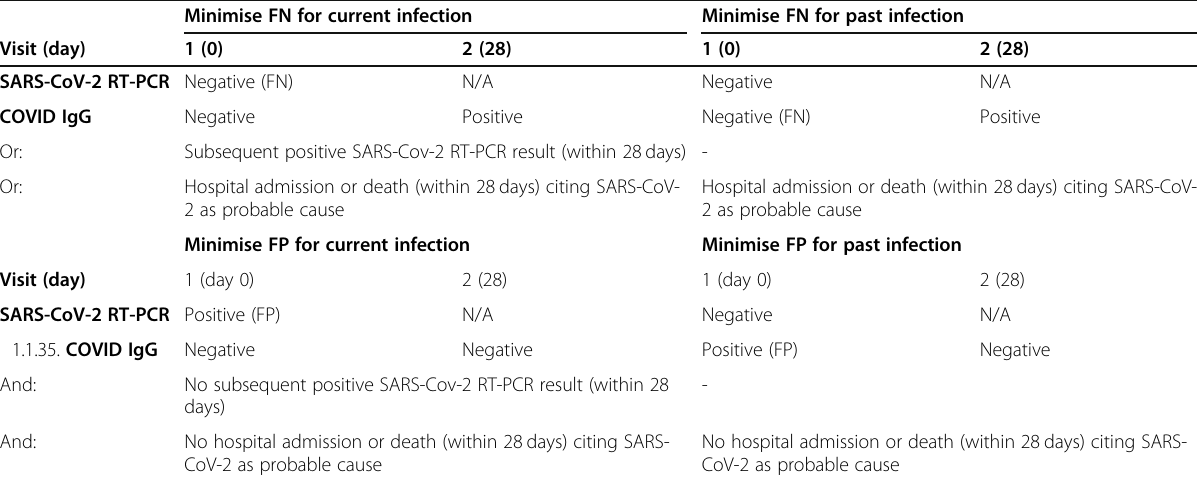
Table 4 Potential use of tests to enhance the reference standard. Information in the table refers to hypothetical combinations of results in which the enhanced reference standard result would be considered different from the original reference standard result. A cell-by-cell interpretation of each scenario